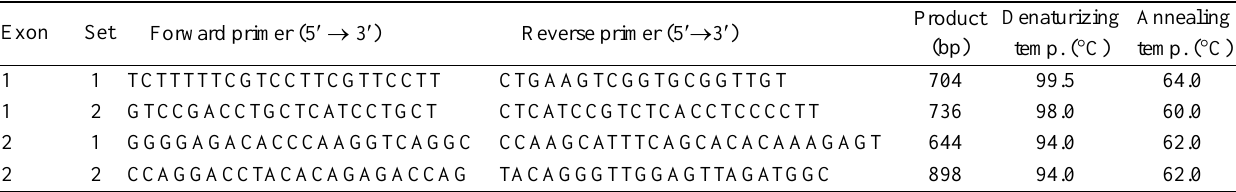
Table 1. Polymerase chain reaction primers for the amplification of the 2 exons in the gene encoding the motilin receptor